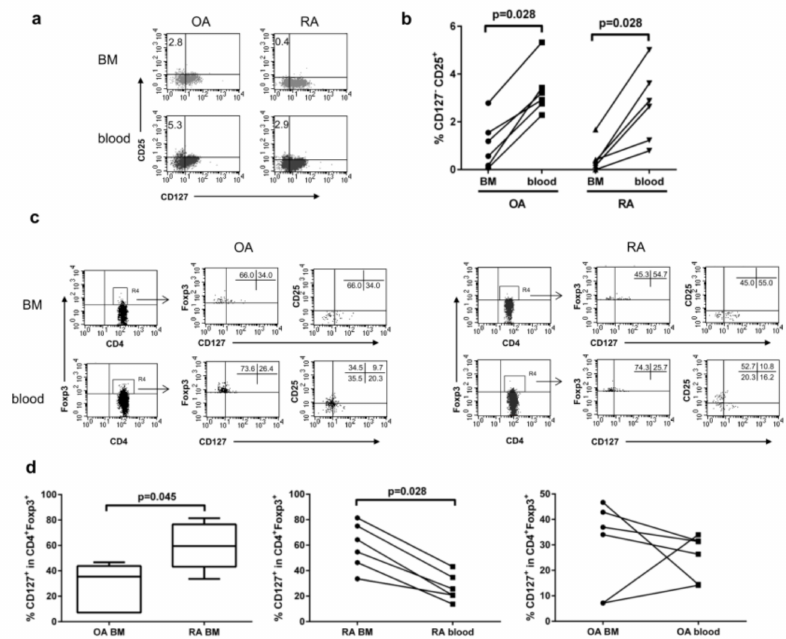
Figure 4. Expression of CD127 by CD4 + FOXP3 + cells from the bone marrow and peripheral blood of OA and RA patients. ( a ) Representative dot plots show the expression of CD127 and CD25 by gated CD4 + T cells in OA and RA BM and peripheral blood. ( b ) The percentage of CD127 − CD25 + among CD4 + T cells from the BM and peripheral blood of the same patient ( n = 6). Individual results are shown as dots. Comparison of the BM with the blood from the same patient (done separately for OA and RA patients) was analyzed by the Wilcoxon test. ( c ) Representative dot plots show CD127 and CD127 together with CD25 expression by gated CD4 + FOXP3 + cells in the BM and peripheral blood of OA and RA patients. ( d ) The percentage of CD127 + cells among CD4 + FOXP3 + T cells from the BM of OA and RA patients (chart on the left), and the BM and peripheral blood of the same patient (RA—chart in the middle, OA—chart on the right; n = 6). Data on the left chart are presented as median with a min–max range, and di ff erences between groups of patients were analyzed by Mann–Whitney U-test. On the remaining two charts, individual results are shown as dots, and a comparison of the BM with the blood from the same patient was analyzed by the Wilcoxon test (done separately for OA and RA patients). Numbers depicted on dot plots show the frequencies of subset expressing a proper